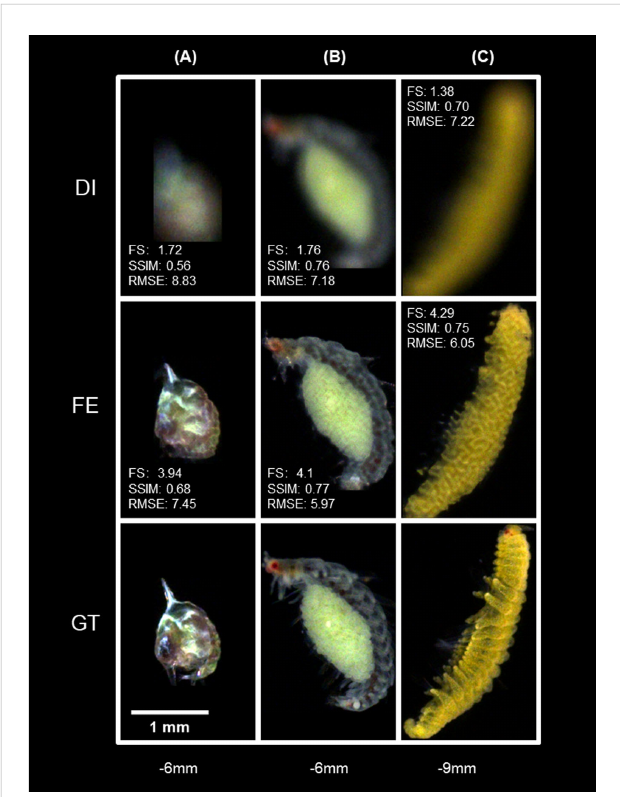
FIGURE 14 Effects of plankton size on the focus-extension performance of IsPlanktonFE. (A) a Megalopa larva at d =-6mm, (B) a Polychate with eggs at d =-6mm, (C) a different Polychate at